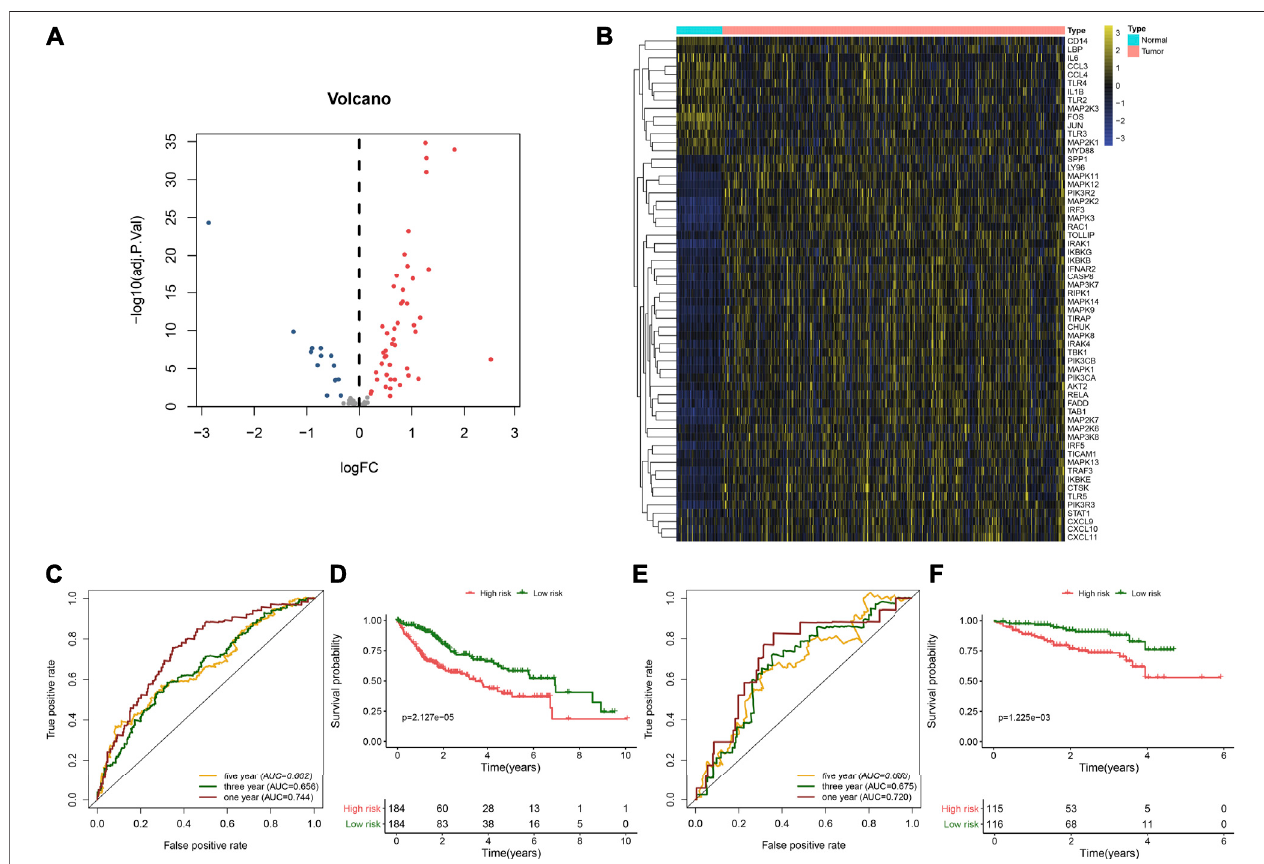
FIGURE 1 | Developing and verifying a TLR-based gene signature in HCC. (A) Volcano diagram of the HCC-speci fi c TLRs with |log2fold-change| > 2 and adjusted p < 0.05 by comparing 368 HCC and 49 normal tissue specimens in TCGA cohort. Blue represents low expression, while red represents high expression. (B) Hierarchical clustering analyses of the expression patterns of previous HCC-speci fi c DEGs in 368 HCC and 49 normal samples in TCGA cohort. Yellow indicates high expression, while blue indicates low expression. (C) ROC curves of one-, three, and 5-year OS for HCC patients based on the RS in the TCGA cohort. (D) Kaplan – Meier curves ofhigh-and low-RS HCC patientsinthe TCGA cohort. Survivaldifferences wereestimated throughlog-ranktests. (E) ROCcurves ofone-,three-, and fi ve-year OS for HCC subjects according to the RS in the ICGC cohort. (F) Kaplan – Meier curves of high- and low-RS HCC subjects in the ICGC